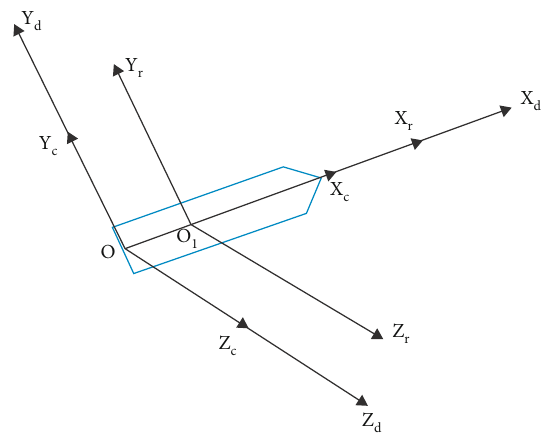
Figure 1: Installation method of